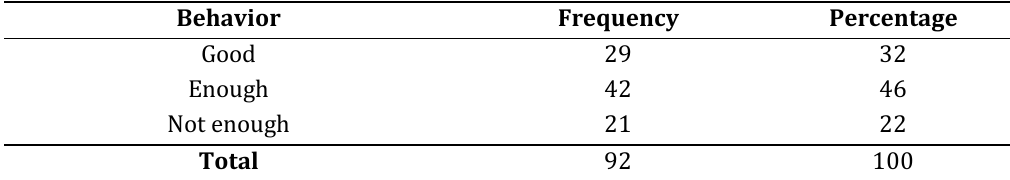
Distribution of frequency and percentage of preventive behavior of increasing uric acid levels Behavior